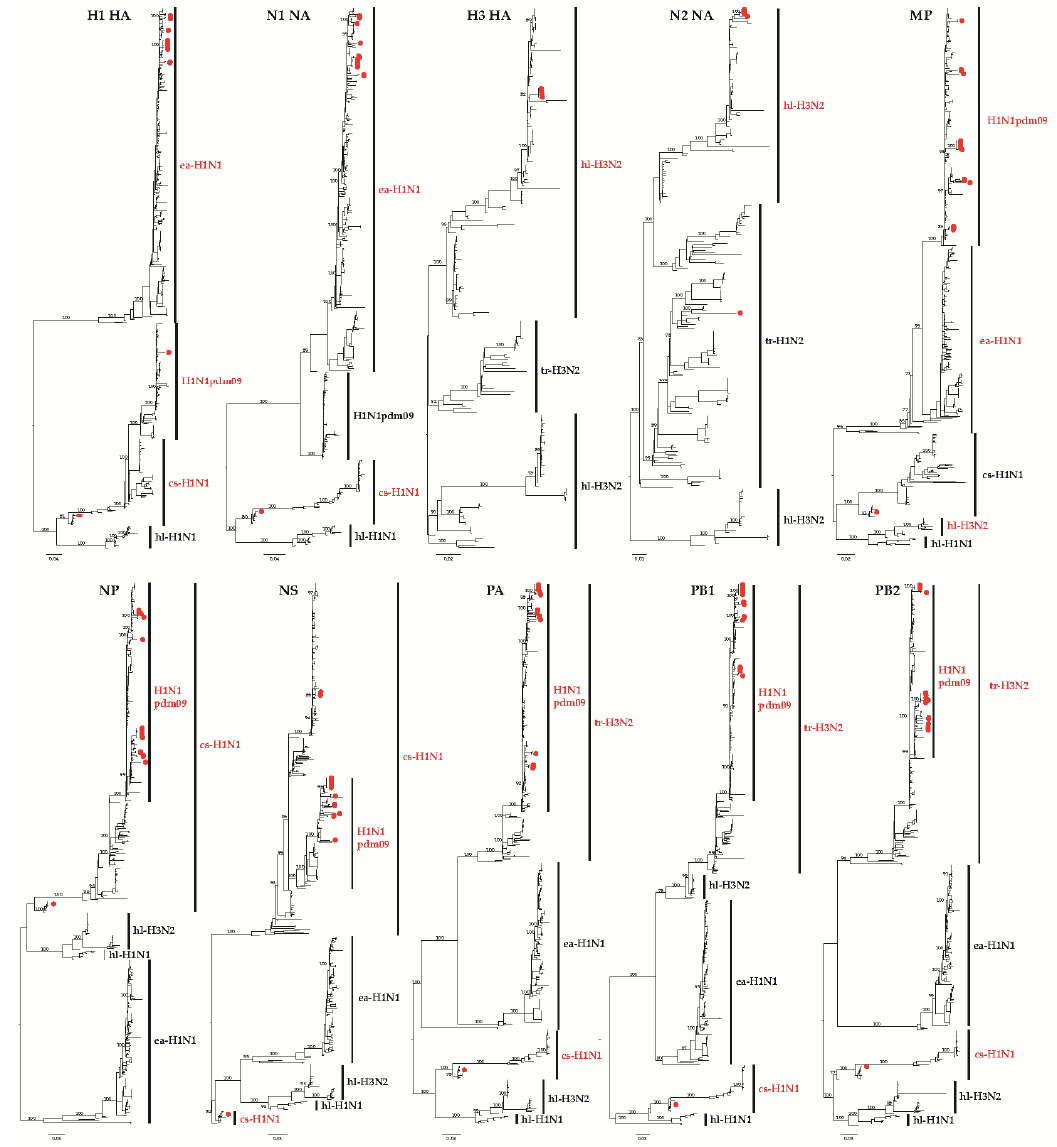
Figure 1. Phylogenetic trees constructed using 20 isolates and the H1 HA ( n = 515), H3 HA ( n = 184), N1 NA ( n = 414), N2 NA ( n = 240), MP ( n = 460), NS ( n = 454), PA ( n = 432), PB1 ( n = 440), and PB2 ( n = 437) gene segments available from GenBank. The 20 new swine influenza virus (IAV-S) isolates are marked with red dots.